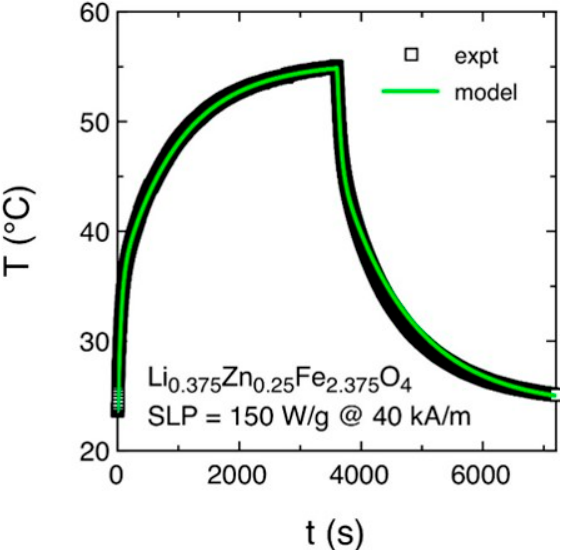
Figure 4. Time dependence of the temperature of the magnetic solution containing LiZn-ferrite powder under an applied field of 40 kA/m at 100 kHz. Black symbols: experimental data. Green line: best fit the by theoretical model.